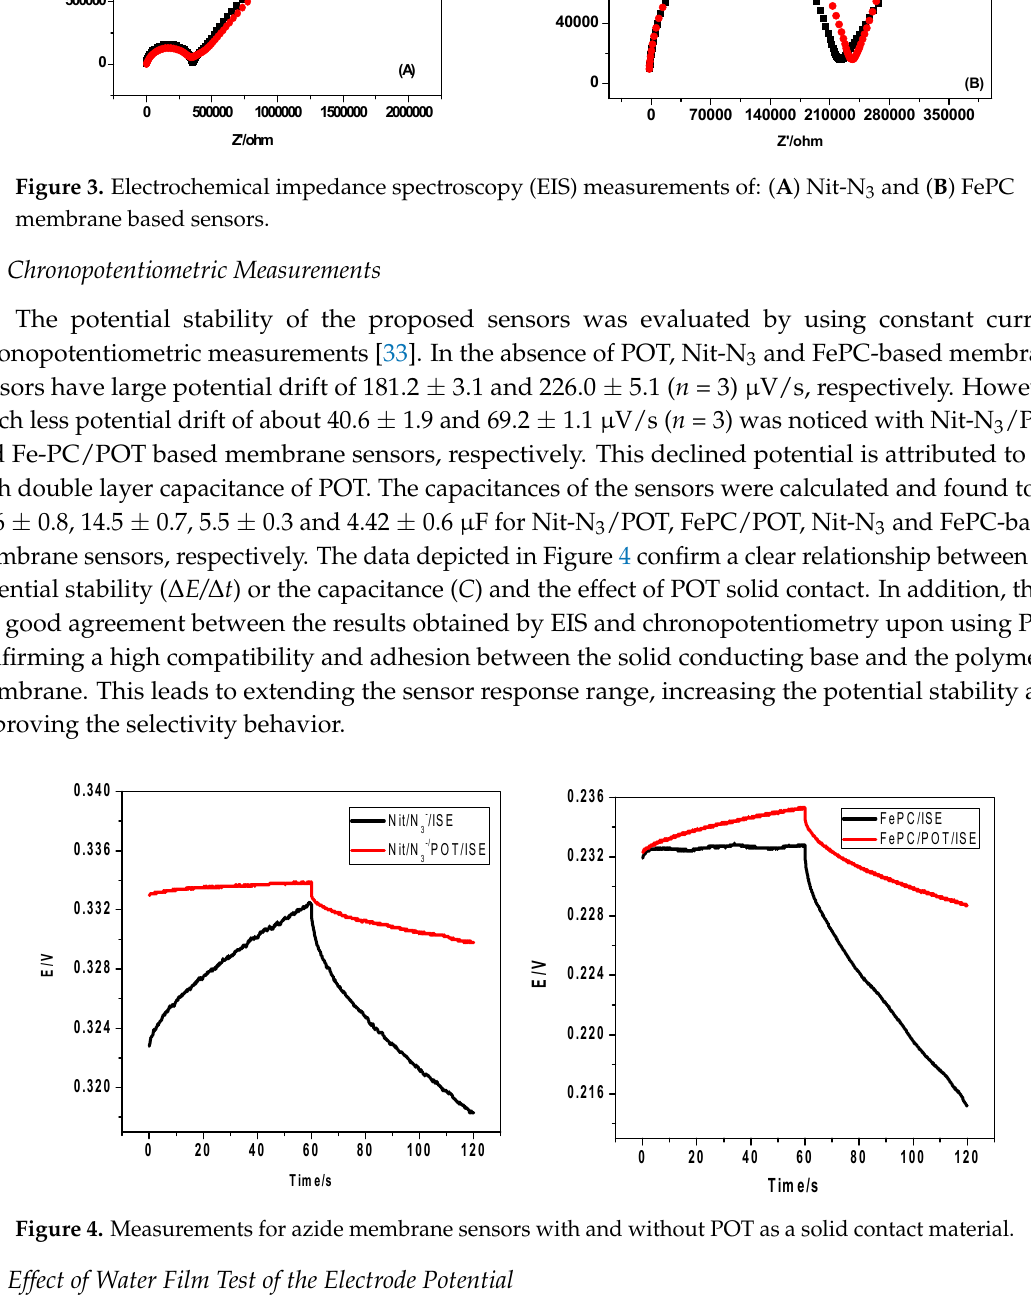
1 h Figure 5. Effect of water-layer on azide membrane sensors with and without POT solid contact. For Nit-N 3 and FePC, a positive potential drift was noticed. This can be attributed to the formation of water layer between the sensing membranes and the conducting substrate. The stable response of Nit-N 3 /POT and FePC/POT-based sensors confirms the absence of a water layer, so the undesirable water layer can be successfully removed by the insertion of the high hydrophobic POT layer between the sensing membrane and the solid conducting substrate.